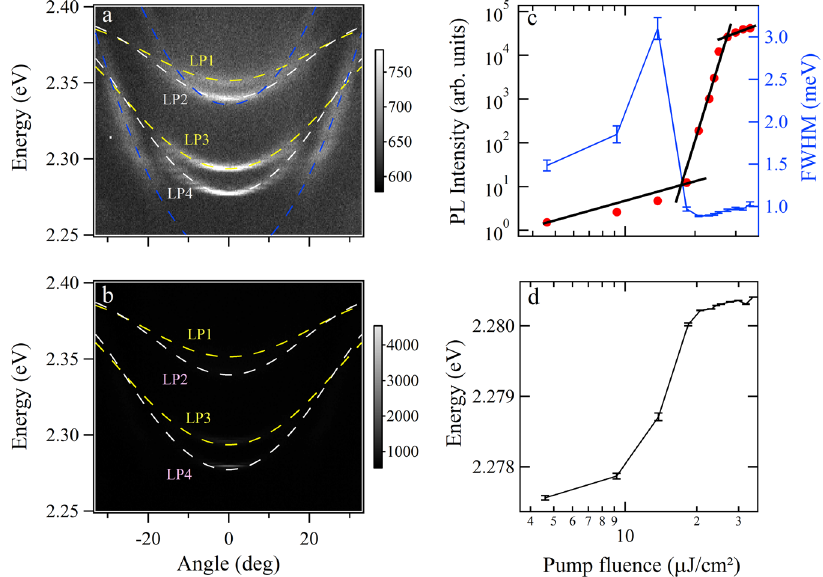
Fig. 2 Polariton condensation in the LC microcavity. a The photoluminescence dispersion of the microcavity below the threshold and ( b ) the condensate spectrum above the threshold for voltage of 2 V. c Integrated intensity and linewidth as a function of the pump fl uence. d Polariton energy peak position as a function of the pump fl uence. The error bars in ( c ) are deviations of the estimated linewidth of polariton modes. And the error bars in ( d ) are deviations of the estimated energy of polariton modes. The blue dashed lines in ( a ) are a guide for the eye to show the modes with large curvature. LP1-LP4 denote low branch polaritons 1 –